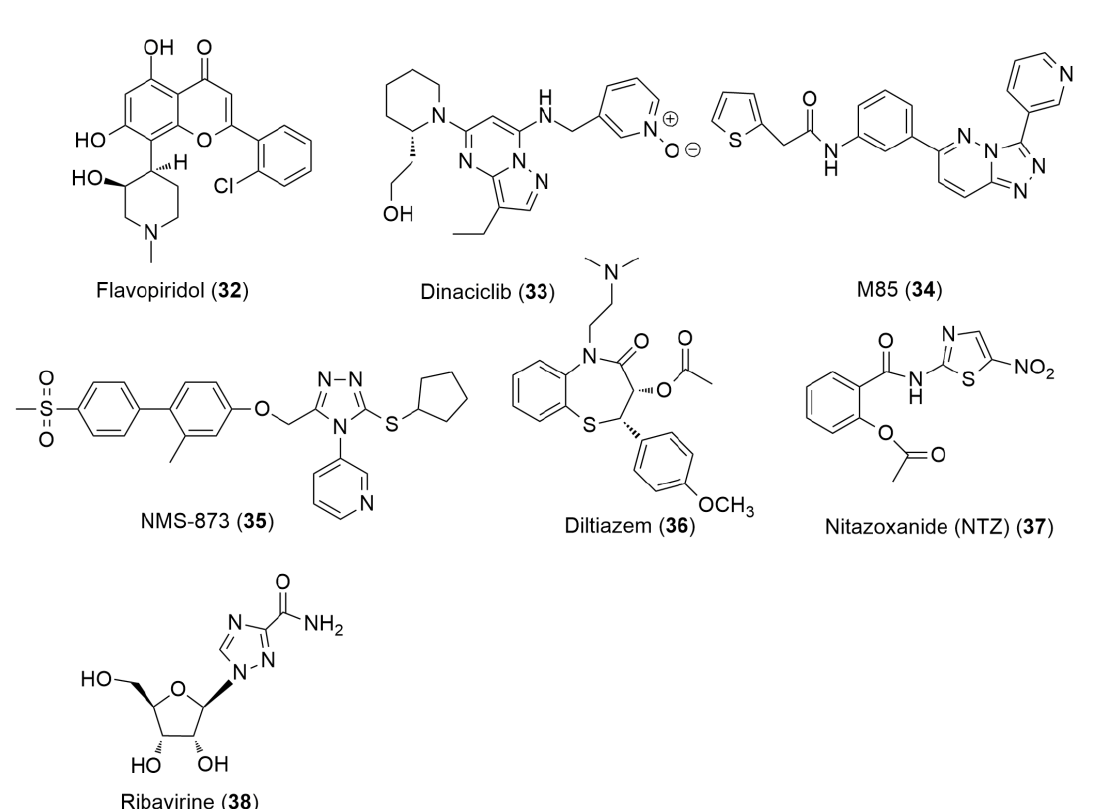
Figure 9. Host-based anti-influenza agents.